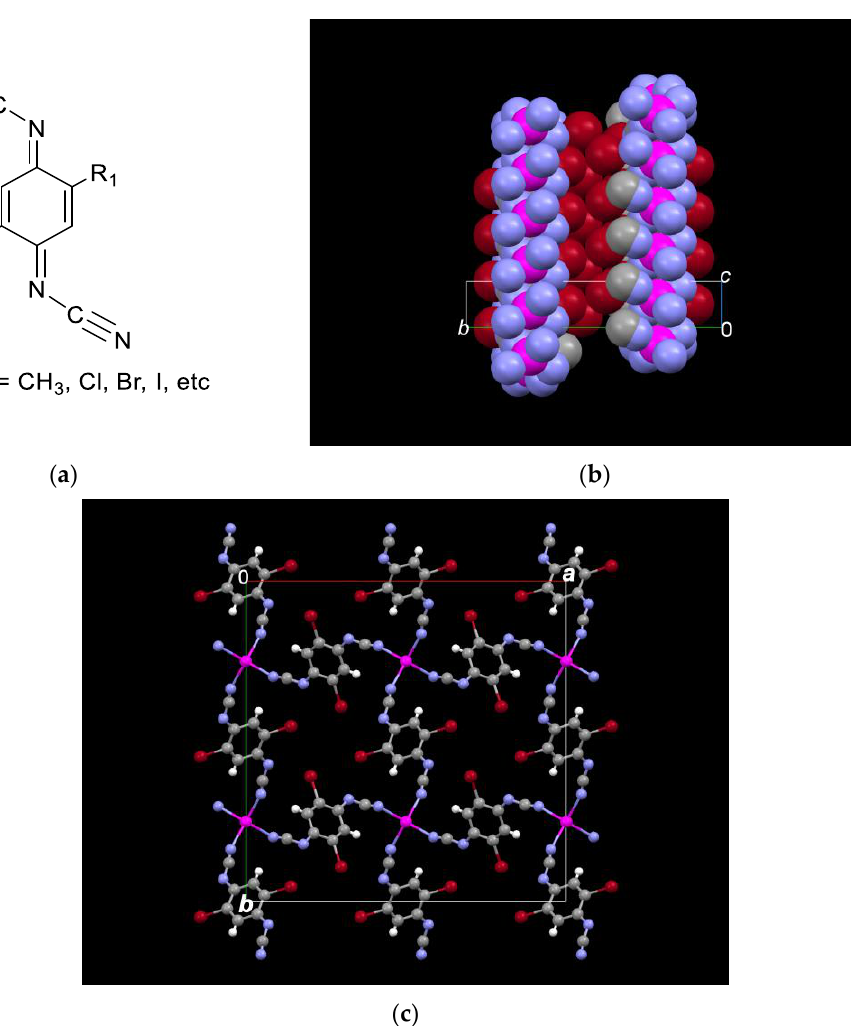
Figure 2. ( a ) The structure of the DCQNI (DCQNI = 2,5-disubstituted N , N’ -dicyanoquionediimine) molecule; ( b ) and ( c ) A typical crystal structure of a Cu salt: Cu(Br 2 -DCNQI) 2 . The white, grey, purple, pink, and dark-red spheres designate H, C, N, Cu, and Br atoms, respectively. Note that every -NCN group at the end of DCNQI makes a coordination bond with a Cu ion in a tetrahedral geometry. Reproduced and modified from Refs. [519] and [520] with permission.